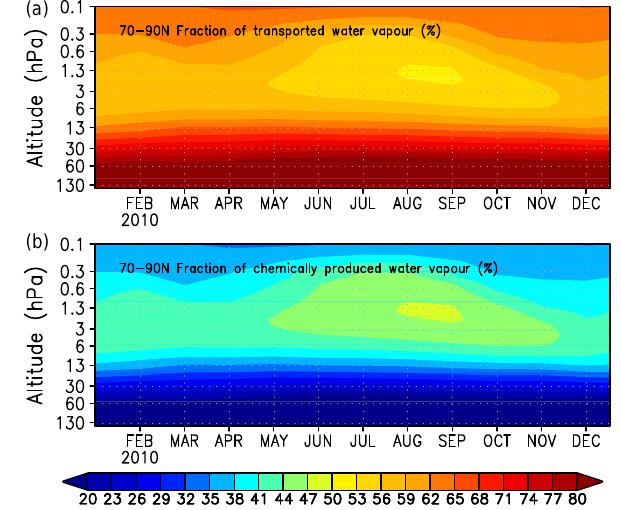
Figure 3. Monthly mean of (a) fraction of transported water vapour and (b) fraction of chemically produced water vapour (%) for 2010 calculated over 70–90 ◦